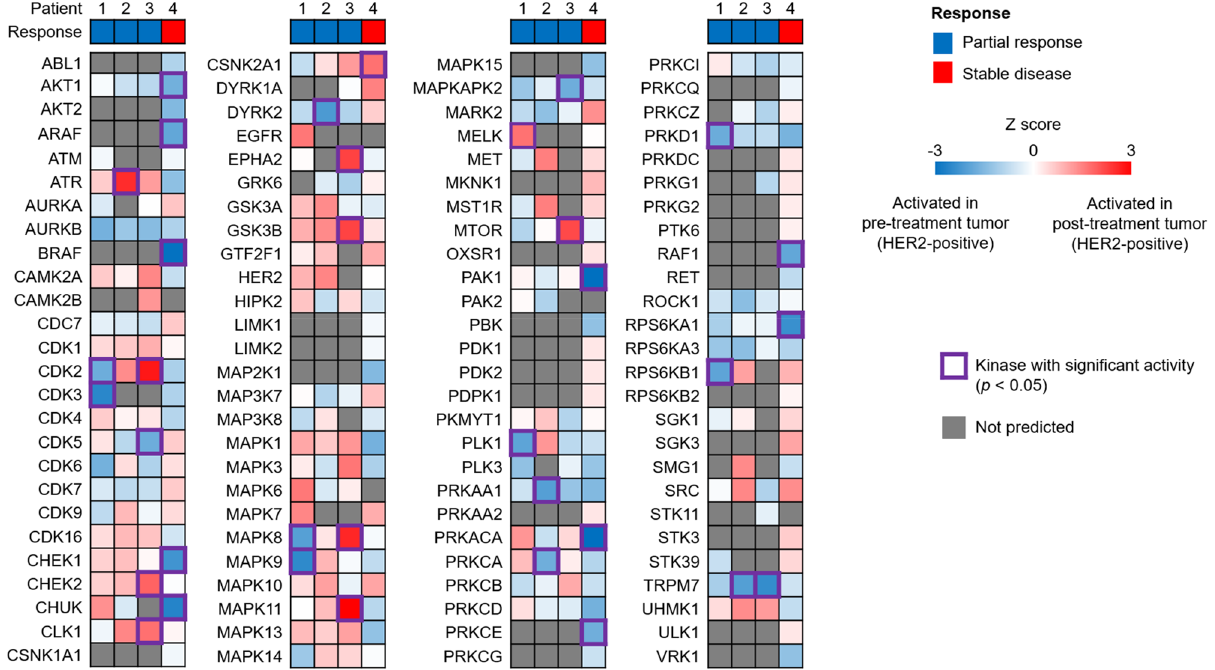
Figure 6. Individual kinome profiling of post-treatment HER2-positive gastric cancer in comparison with the corresponding pre-treatment HER2-positive gastric cancer. Information on the responses to drug therapy is shown at the top of the kinome profiling. Kinases with significant activity ( p < 0.05) are depicted by purple lines. Kinases with no information are filled with